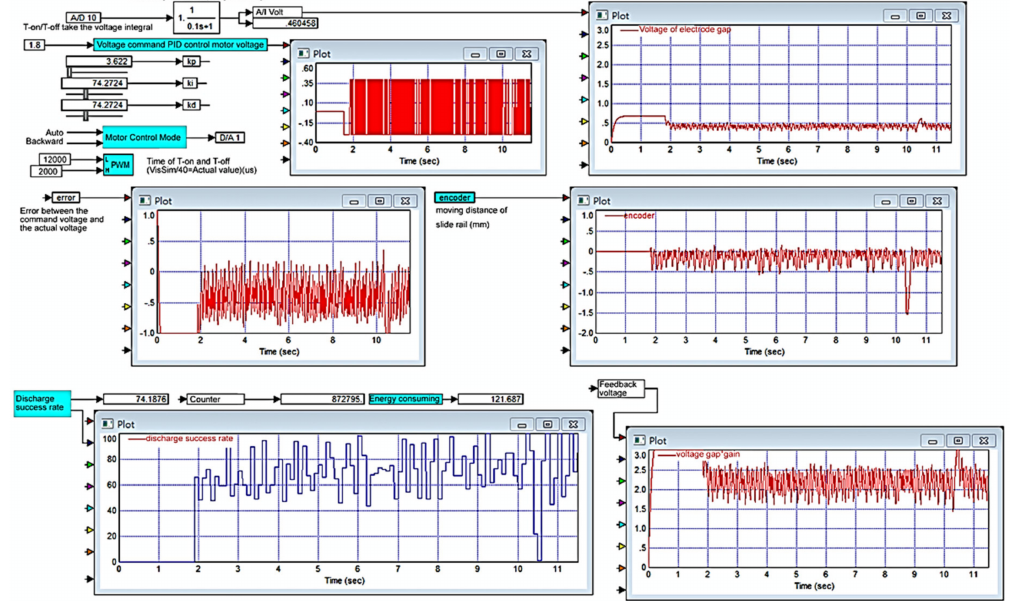
Figure 10. Process monitoring chart for preparing nano-bi. Kp = 3.622, Ki = 74.2724, and Kd =